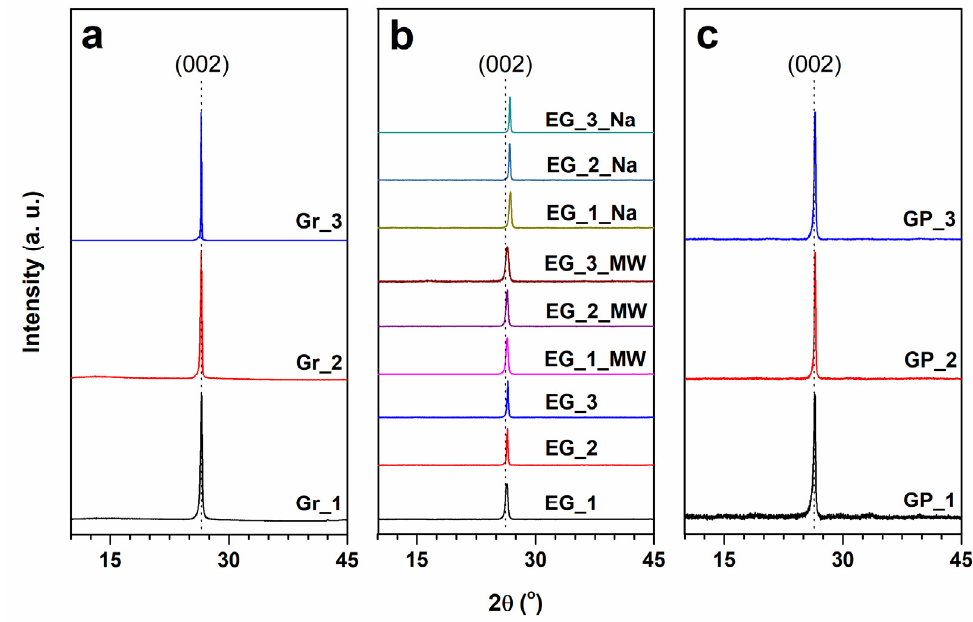
Figure 3. XRD patterns of pristine graphite ( a ), EG ( b ), and EG samples modified with PPy ( c ).